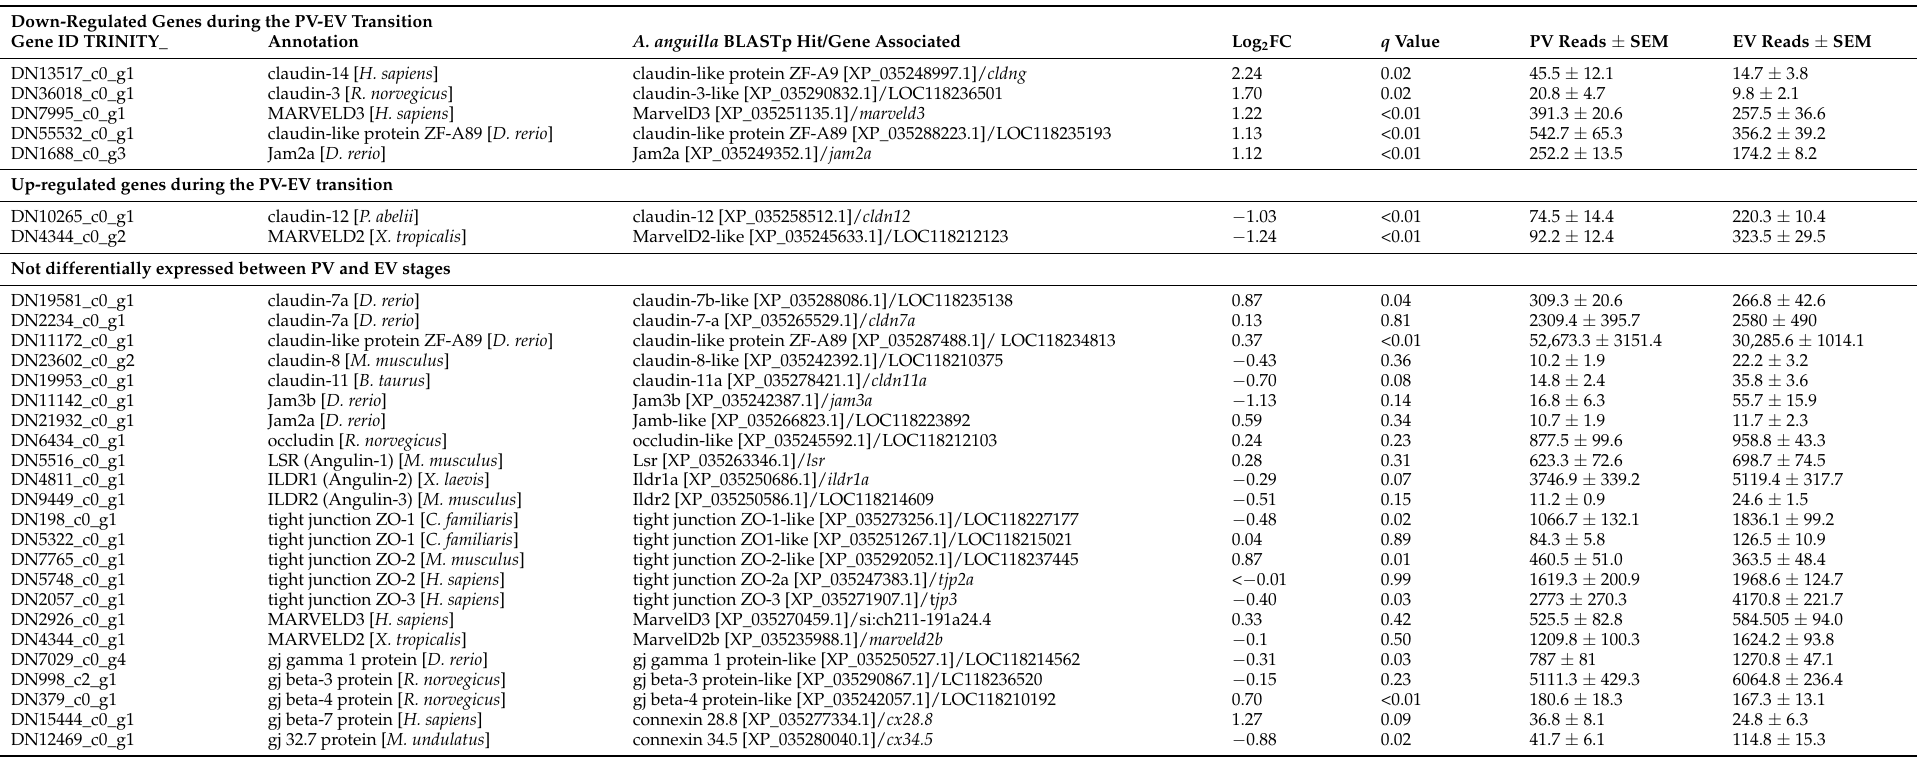
Table 1. Expression of genes encoding cell junctions during progression from the PV stage to the EV stage in A. australis ovarian tissue. Genes encoding tight junction proteins as well as gap junction (gj) proteins are shown. Both differentially and not differentially expressed genes are included, along with their respective q values and log 2 FC. Fold change in expression is represented by log 2 FC and it is relative to the PV stage. A positive log 2 FC indicates up-regulation in the PV stage and down-regulation in the EV stage, while a negative log 2 FC means up-regulation in the EV stage and down-regulation in the PV stage. Significant DEGs were considered when showing q value < 0.05 and − 1 ≥ log 2 FC ≥ 1, representing a 2-FC. Gene names are based on the A. anguilla top hit ( A. anguilla genome, (mean ± SEM) are shown for each stage (n = 6 per